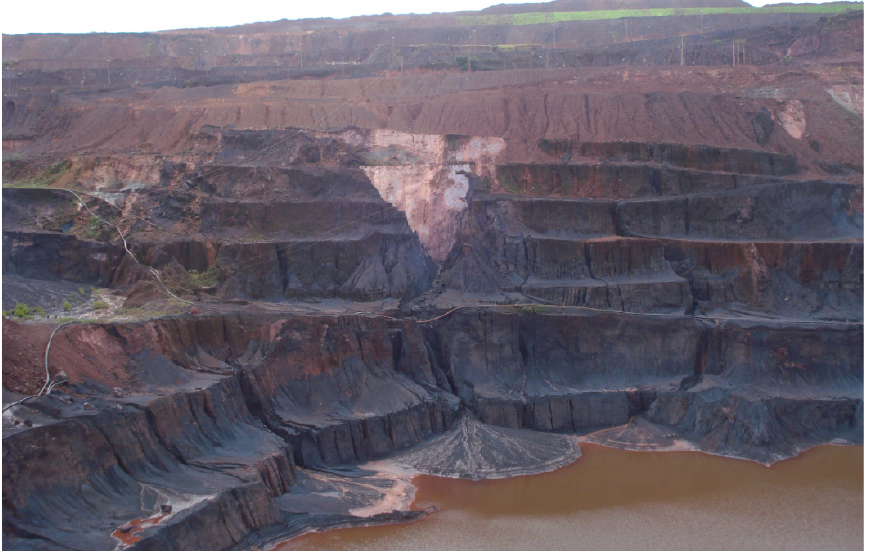
Figure 2. Slope failure due to a geological fault involving at least four cut slopes of the east flank of Pit 1. Note the dismantling of the slopes due to erosional effects, which indicates the dominance of low-cohesion materials. Picture taken on 15 March